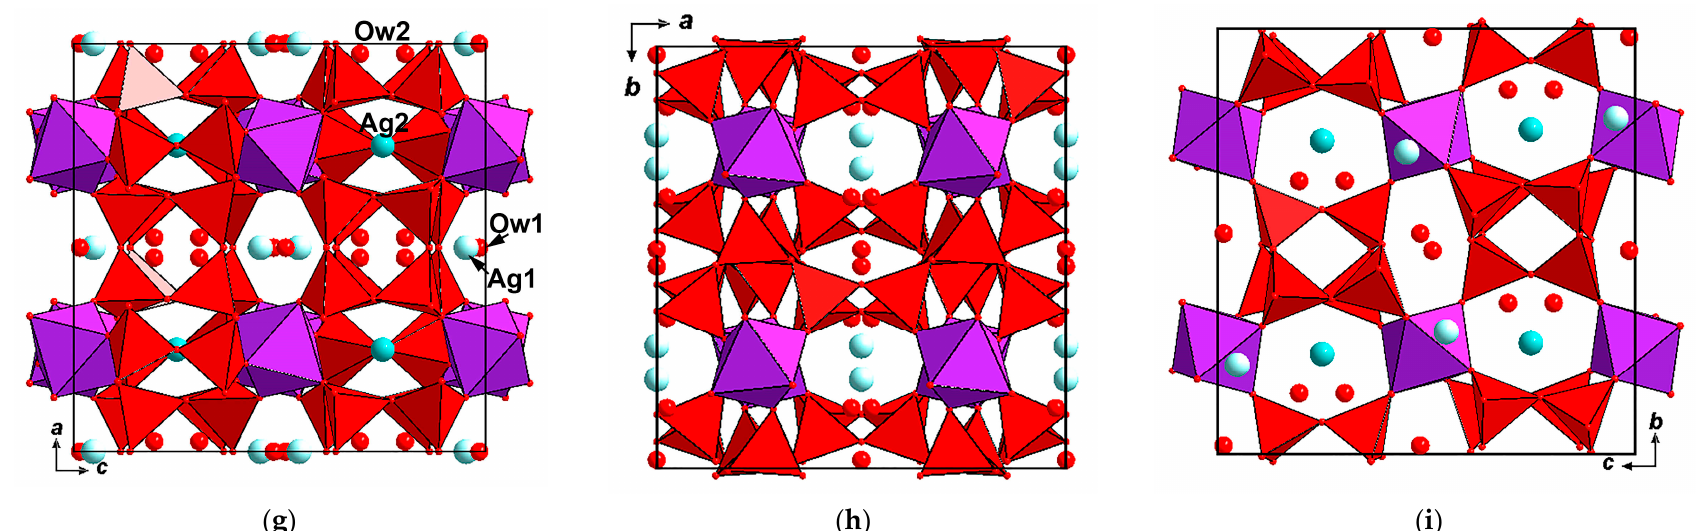
Figure 6. The crystal structures in three projections of: initial elpidite from the Lovozero alkaline massif ( a – c ), initial elpidite from Khan Bogdo (drawn after [3]) ( d – f ) and Ag-exchanged form of elpidite from Khan Bogdo [only the main Ag sites are shown] ( g – i ). The unit cells are outlined.